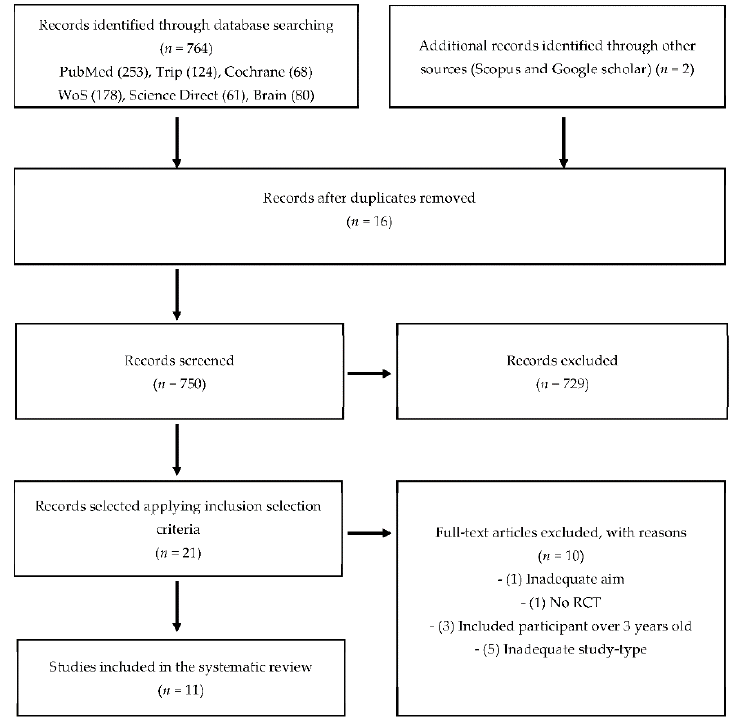
Figure 1. Flowchart. RTC: Randomized controlled trial